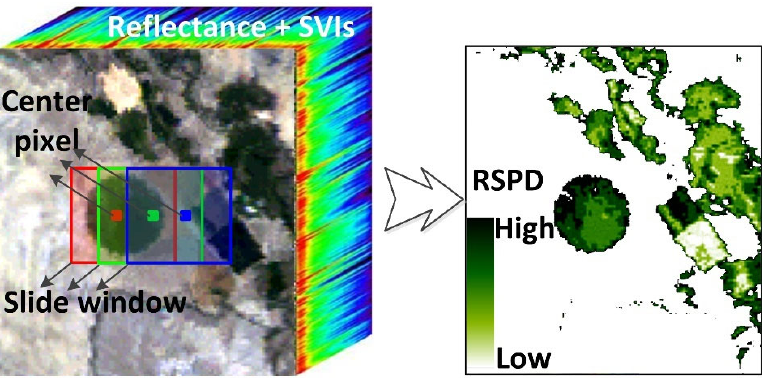
Figure 1. Conceptual graph of the method to calculate RSPD .